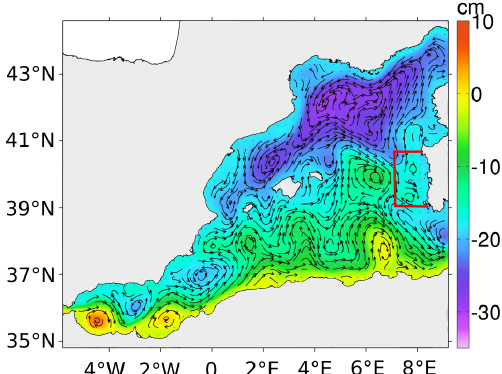
Figure 1. Sea surface height annual mean for the year 2014 and cor- responding surface geostrophic currents from the Western Mediter- ranean OPerational forcasting system (WMOP) model. The REP14- MED sea trial area is highlighted in